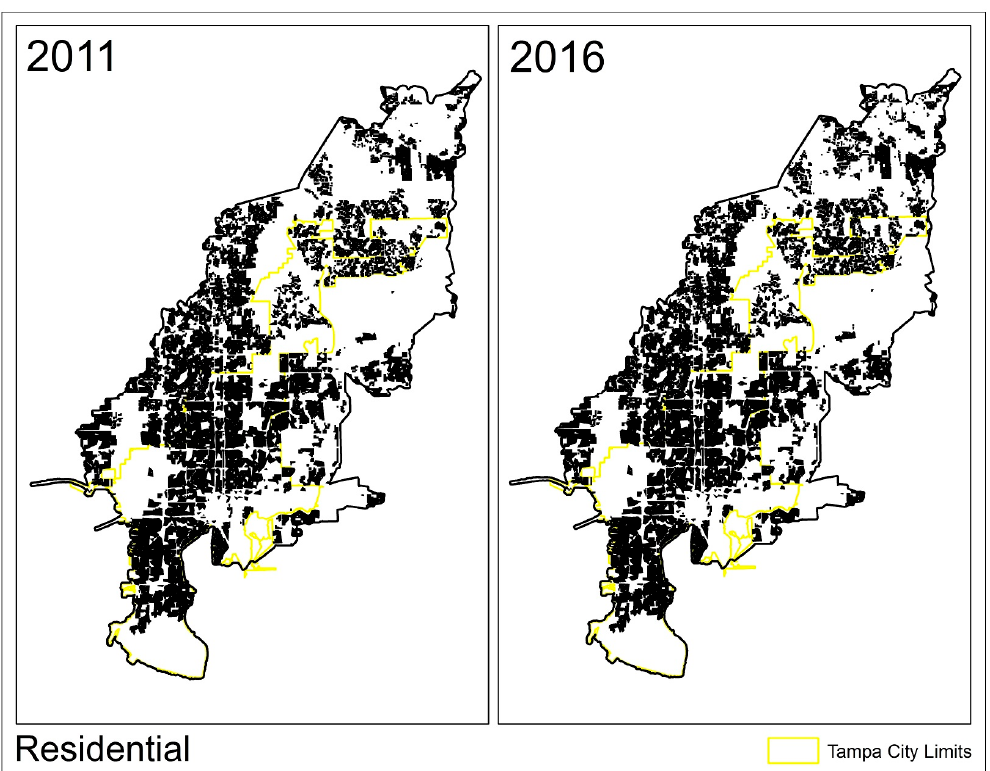
Figure A9. Observed (2011) and Modeled (2016) LULC distribution for the “Residential” class.